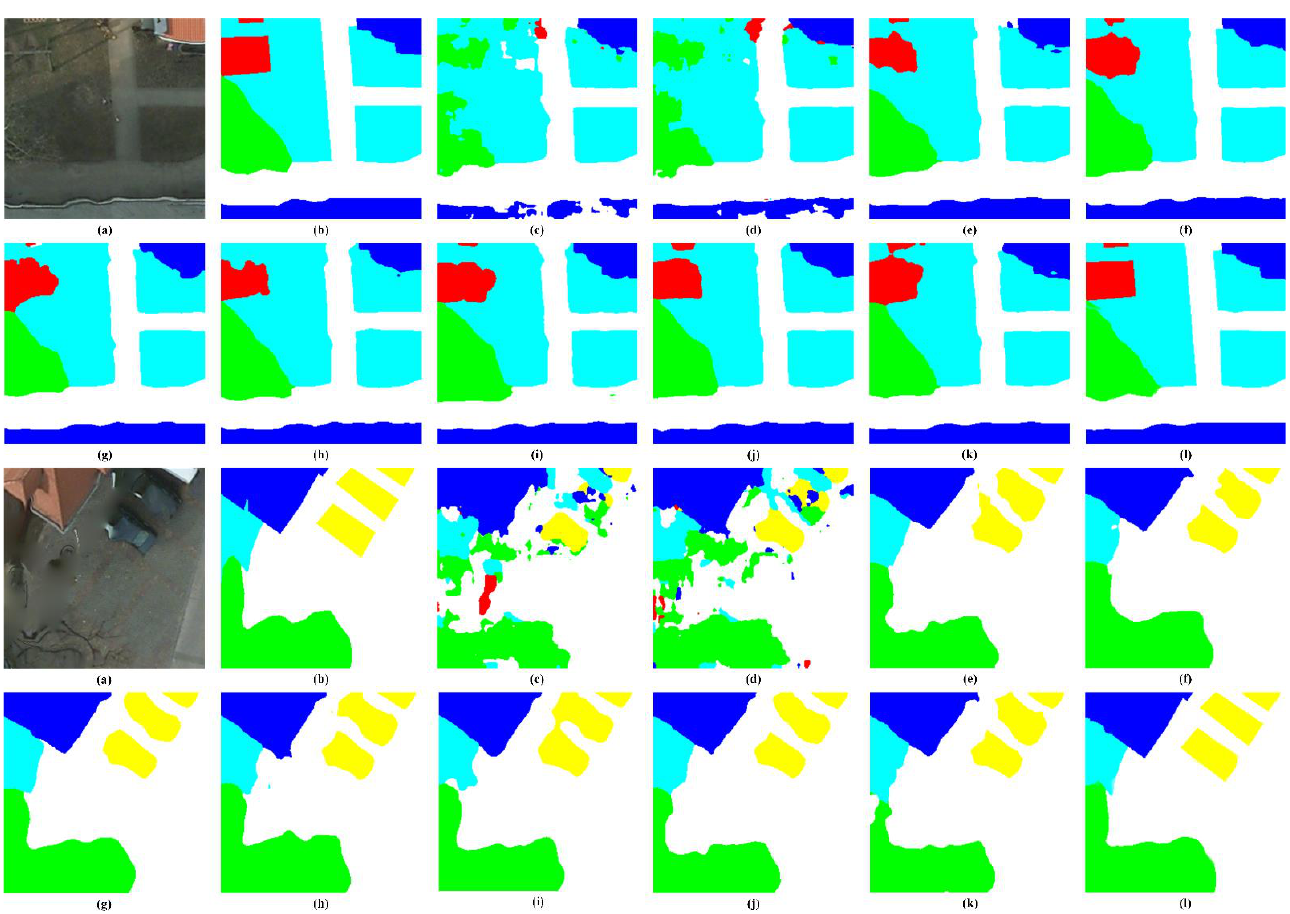
Figure 8. Visual inspections of random samples from Potsdam test set. ( a ) raw image, ( b ) ground truth, ( c ) SegNet, ( d ) U-Net, ( e ) DeepLab V3+, ( f ) CBAM, ( g ) DANet, ( h ) NLNet, ( i ) OCRNet, ( j ) ResUNet-a, ( k ) SCAttNet, ( l ) EDENet.